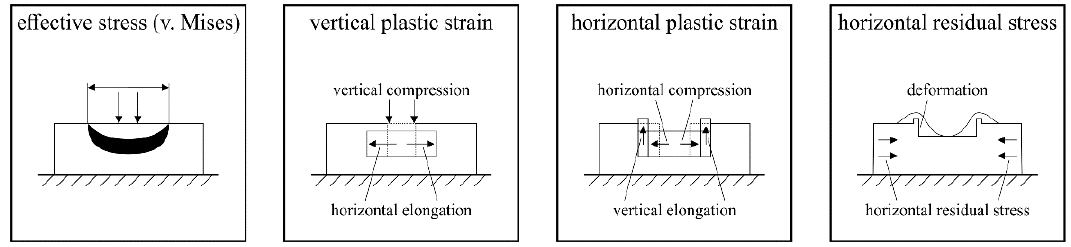
Figure 5. Schematic view of residual stress inducing mechanisms due to deep rolling, according to [25].